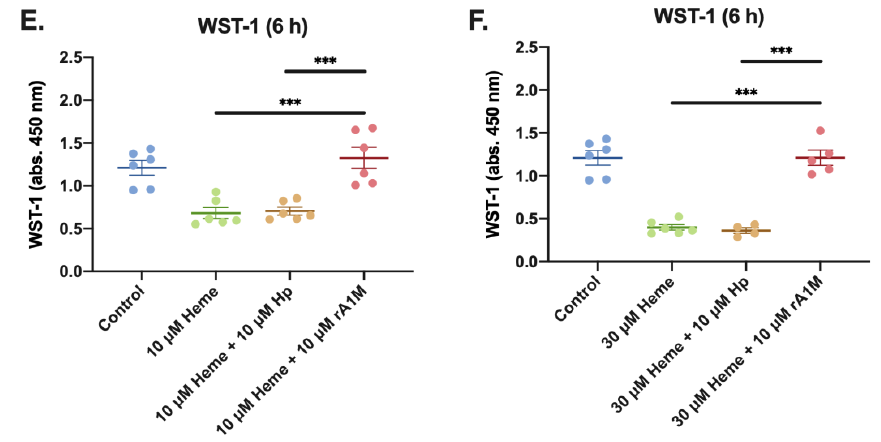
Figure 1. Cytoprotective effects of rA1M after exposure to heme. HK-2 cells were exposed to 5, 10 or 30 µ M heme with or without simultaneous addition of 10 µ M rA1M ( A – F ) or 10 µ M Hp ( E – F ) and cell death was analyzed by LDH levels ( A – B ) in cell culture media, and cell viability was measured by WST-1 ( C – F ) after 6 h ( A , C , E , F ) and 24 h ( B , D ). Values are presented as mean ± SEM, LDH n = 6, WST n = 3–6. Differences between groups were analyzed using one-way ANOVA with post hoc Sidak. * P < 0.05, *** P < 0.001.